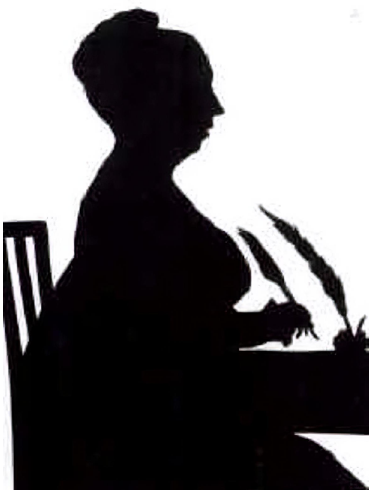
Fig. 1 Silhouette of Birgithe Kühle (1762‒1832), identified by a family biography as probably made by Franz Liborius Schmitz, c. 1816 in Assens. Lokalhistoriewiki.